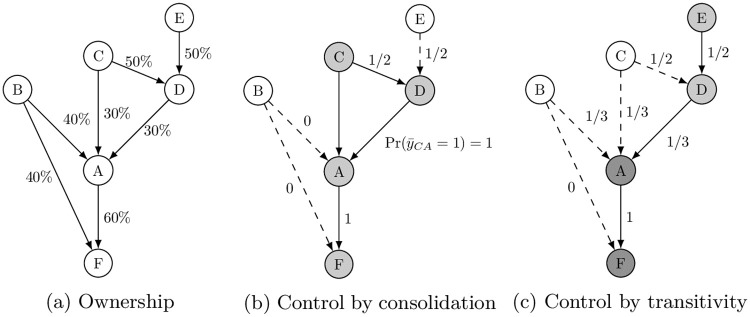
Indirect ownership & control.